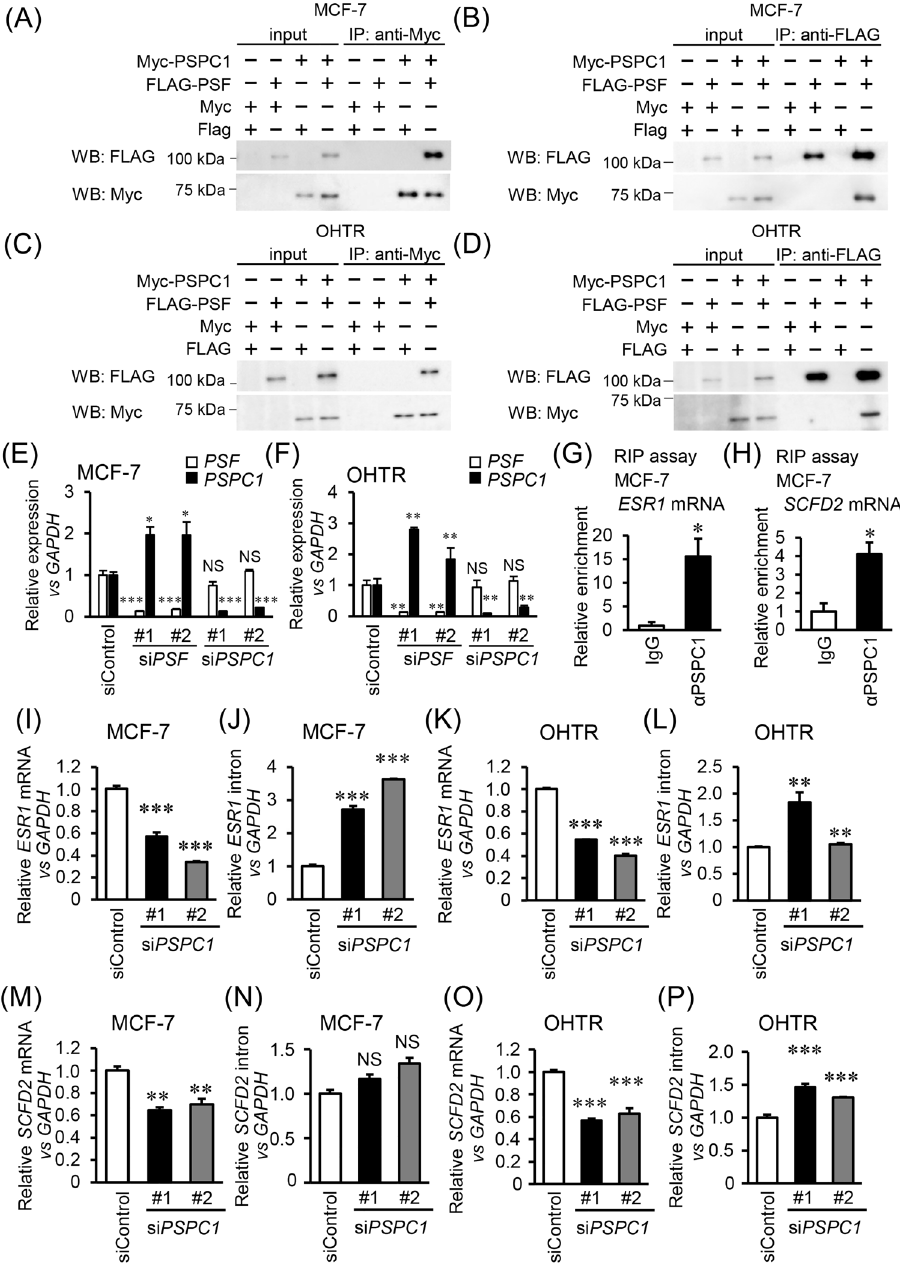
Figure 2. PSPC1 post-transcriptionally modulates ESR1 and SCFD2 expression. ( A , B ) MCF-7 cells were transfected with plasmids encoding indicated proteins and cell lysates were prepared 24 h after transfection. Myc-tagged PSPC1 (Myc- PSPC1) and FLAG-tagged PSF (FLAG-PSF) were immunoprecipitated with Anti-c-Myc Agarose ( A ) or ANTI-FLAG M2 Affinity Gel ( B ), respectively. Precipitated proteins were eluted with 2 × SDS sample buffer and subjected to Western blot analysis with anti-Myc and FLAG antibodies. Unprocessed original scans of the blots are shown in Supplementary Fig. S3. ( C , D ) The same experiments as ( A ) and ( B ) were performed using OHTR cells. Unprocessed original scans of the blots are shown in Supplementary Fig. S3. ( E , F ) PSF and PSPC1 mRNA levels in MCF-7 ( E ) and OHTR ( F ) cells transfected with siRNAs for PSF and PSPC1 for 48 h were analyzed by qRT-PCR. Relative PSF and PSPC1 mRNA levels were normalized to GAPDH mRNA level in each sample and presented as mean fold change ± SEM ( n = 3). * P < 0.05; ** P < 0.01; *** P < 0.001; NS not significant, two-way ANOVA. ( G , H ) Interaction of PSPC1 with ESR1 ( G ) and SCFD2 ( H ) mRNAs in MCF-7 cells. RNA-immunoprecipitation (RIP) assay was performed using anti-PSPC1 antibody or normal mouse IgG. ESR1 and SCFD2 mRNA levels were analyzed by qRT-PCR. Each mRNA level was normalized to GAPDH mRNA level in each sample. The fold enrichment relative to IgG was shown as mean and SEM ( n = 3). * P < 0.05, Student’s t -test. ( I – P ), Effects of PSPC1 knockdown on ESR1 mRNA ( I , K ) and intron ( J , L ) or SCFD2 mRNA ( M , O ) and intron ( N , P ) levels in MCF-7 and OHTR cells analyzed by qRT-PCR. Relative expression levels of these RNAs were normalized to GAPDH mRNA level in each sample and presented as mean fold change ± SEM compared with siControl ( n = 3). ** P < 0.01; *** P < 0.001; NS not significant, two-way